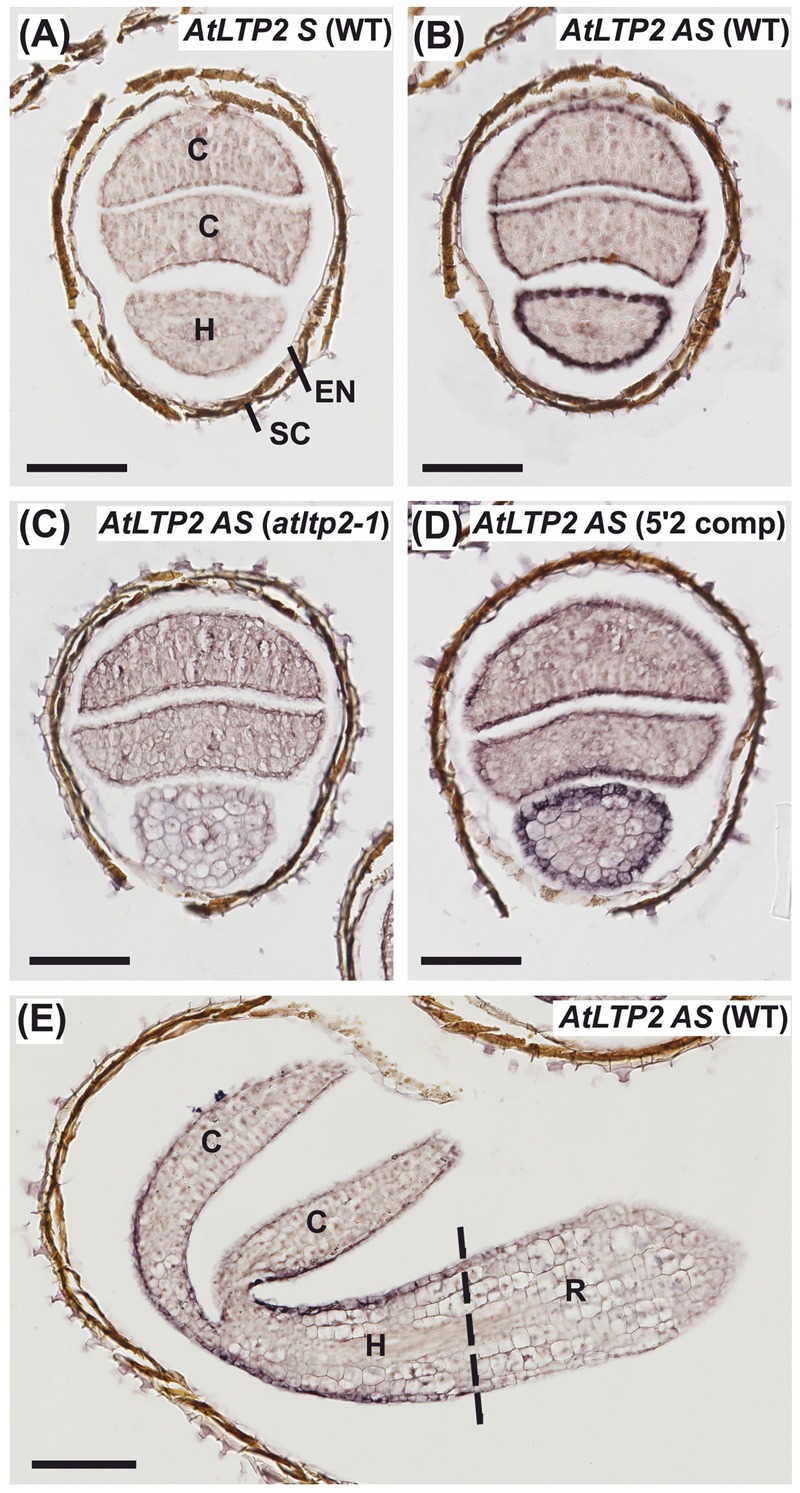
AtLTP2 expression is restricted to epidermal cells of cuticle-containing hypocotyl and cotyledons from etiolated seedlings. (A–E) ISH was performed with AtLTP2 antisense (AS) and sense (S) probes on 24-h-old serial cross-sections (A–D) and 30-h-old etiolated seedling longitudinal sections (E) of WT, atltp2-1 and one complemented line (5′2 comp). The AtLTP2 S probe (A) allowed showing the low hybridization background level within the etiolated seedling tissues (C, cotyledons; H, hypocotyls; R, radicle) and in the endosperm (EN), and to visualize the natural brown color of the seed coat (SC). Scale bars: 100 μm.